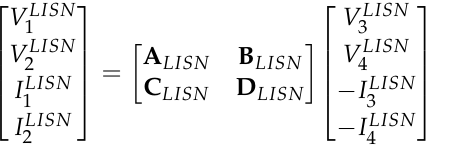
and V LISN , the first step is to measure LISN V and LISN V , the fi rst step is to meas- 2 1 1 2 and V LISN . LISN V and LISN V . 3 4 3 4